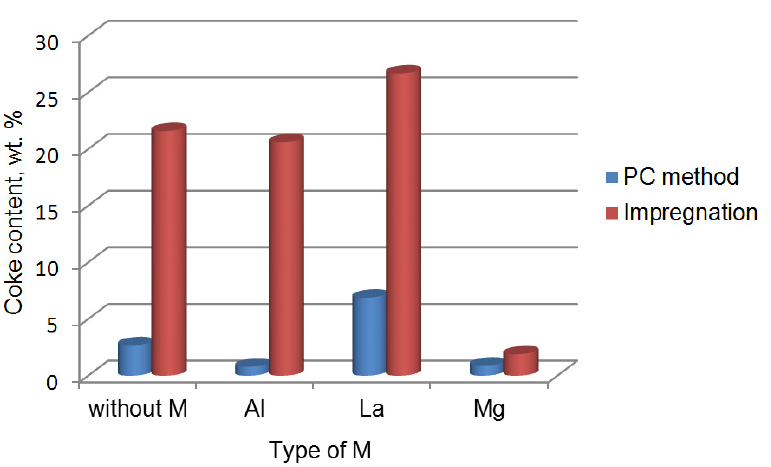
Figure 20. Effect of preparation method of (CeM) 0.8 Ni 0.2 O y on the content of coke formed during screening tests of samples for the bi-reforming of methane. M/Ce molar ratio is equal to 1.